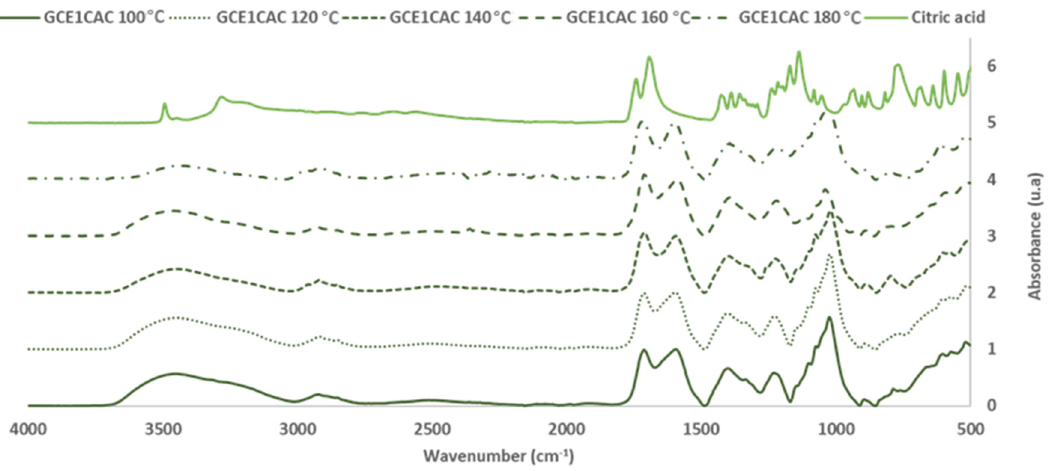
Figure 7. FTIR spectra: Citric acid and Grape cane extract GC E1 cured with citric acid (33% on adhesive weight, dry basis) at 100–180 ◦ C (400–4000 cm − 1 ).